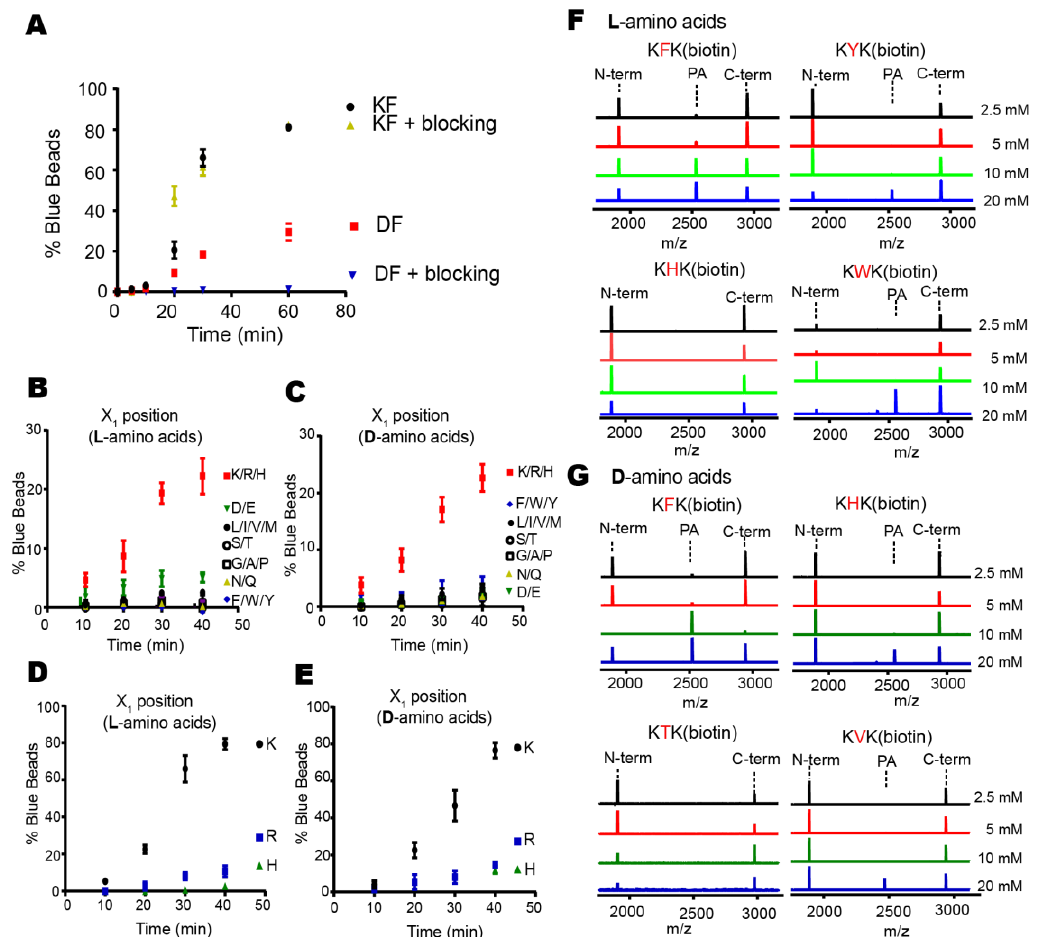
Figure 4. The OBOC-based approach allows identification of good nucleophiles. ( A ) Beads containing the KF dipeptide showed much higher fractions of blue beads than those with DF in the optimized on-bead reaction. The blocking of beads with bovine serum albumin (BSA) helped to reduce the background blue beads with DF. The error bars show averages ± 1 SD (n = 3). ( B , C ) Seven groups of OBOC libraries carrying the N-terminal amino acids of similar properties were individually subjected to the on-bead screening experiments. Only the library with positive side-chains (K, R, and H) showed a significant fraction of blue beads. Peptide libraries with only L -amino acids ( B ) or D -amino acids ( C ) were used. The error bars show averages ± 1 SD (n = 3). ( D , E ) Three OBOC libraries containing N-terminal lysine, arginine, or histidine were individually subjected to the on-bead screening experiments. Only the beads with the N-terminal lysine showed significant blue beads. The peptide libraries with only L -amino acids ( D ) or D -amino acids ( E ) were used. The error bars show averages ± 1 SD (n = 3). ( F , G ) Various peptides bearing the identified dipeptides from the sequencing of blue beads were synthesized in the X 1 X 2 K(biotin) context and subjected to the cleavage reactions (2 µ M DegP and 20 µ M 18–58) in different concentrations. The reaction mixtures were analyzed by MALDI-TOF-MS (n = 1). Peptides with only L -amino acids ( F ) or D -amino acids ( G ) were